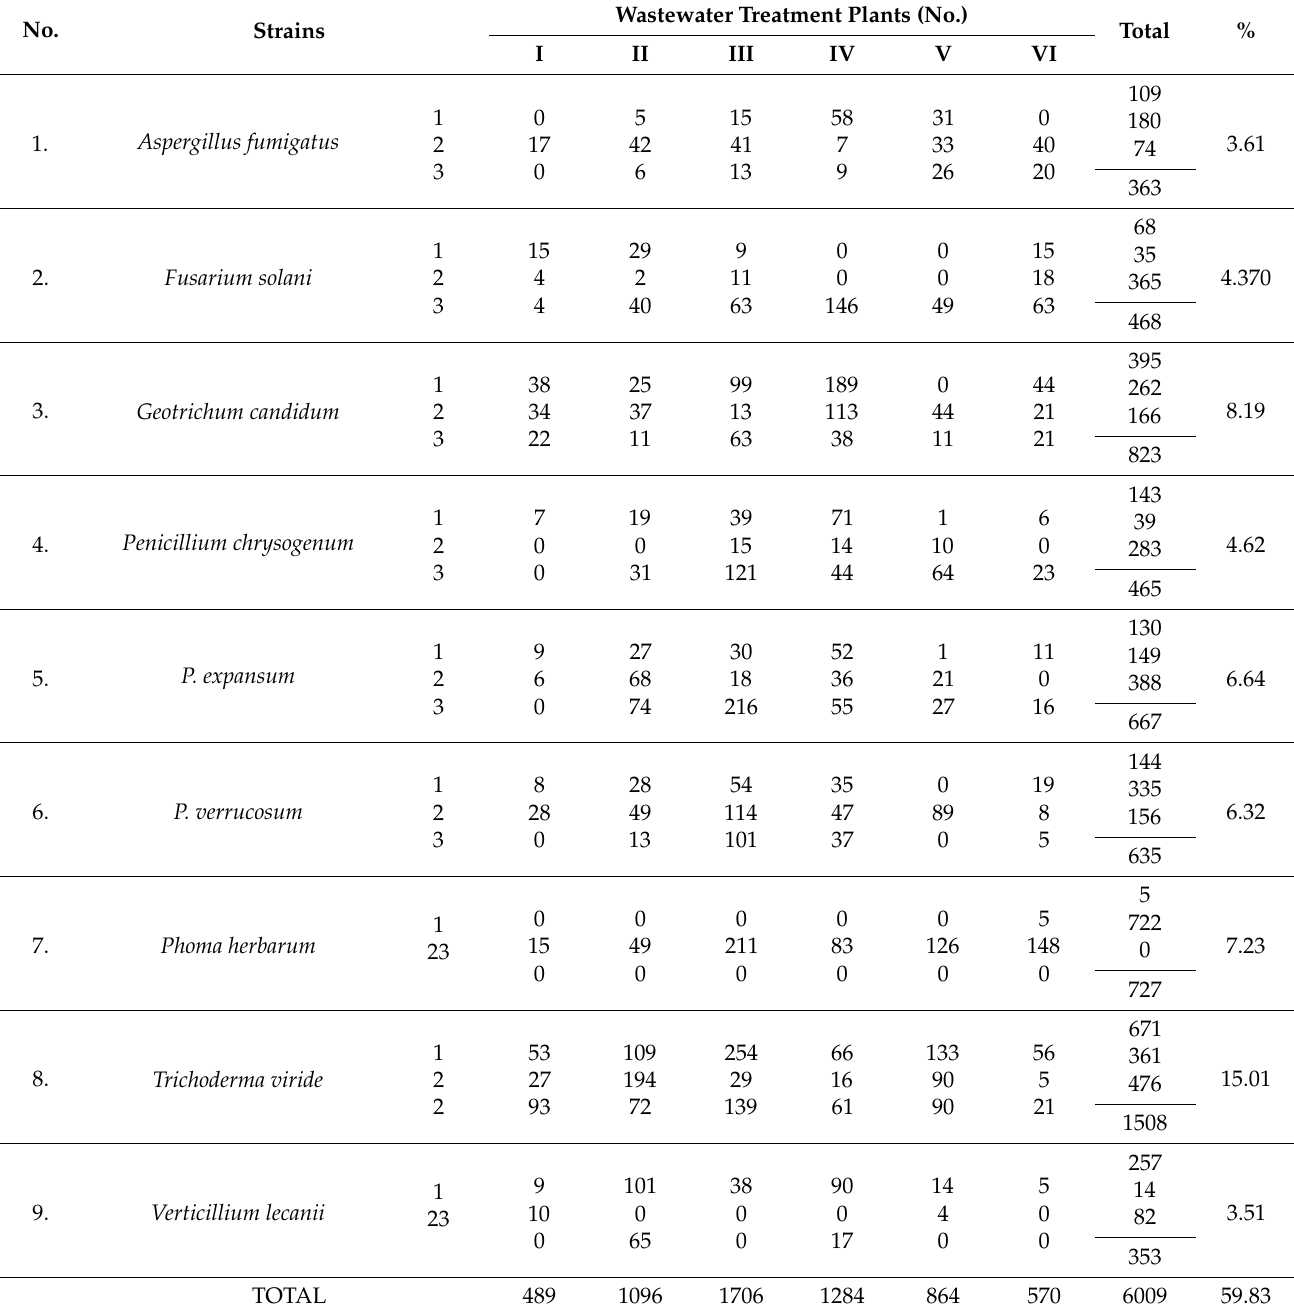
Table 4. Frequency and share (in %) of the dominant species of filamentous fungi (at least 3% of total molds); I—Leitnie, II—Ludwin, III—Jastk ó w, IV—D ˛abrowica, V—Jastk ó w, VI—Sobieszyn; 1—number of strains isolated on Martin medium in 2008, (2) number of strains isolated on Martin medium in 2009, (3) number of strains isolated on Sabouraud medium in